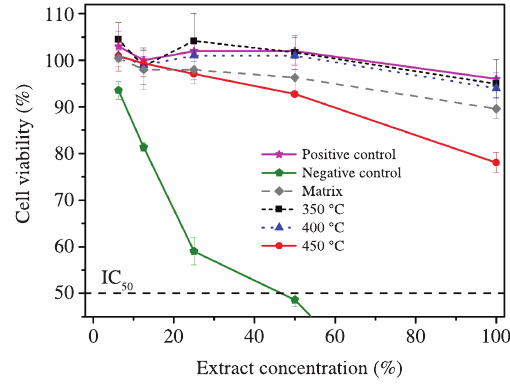
Figure 7. Cell viability of positive and negative control in detail; samples untreated and nitrided at 350, 400 and 450